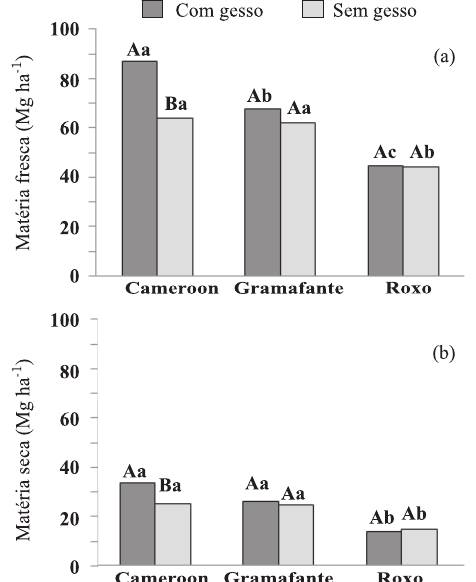
figura 2. produção de matéria fresca (a) e seca